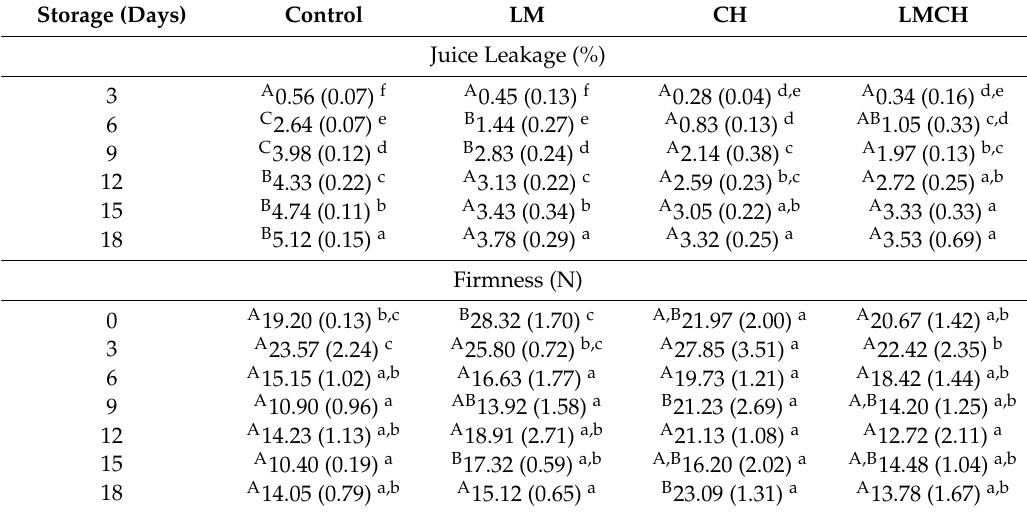
Table 1. Physical properties of fresh-cut cantaloupe with and without EC (control) during 18 days of storage at 4 ◦